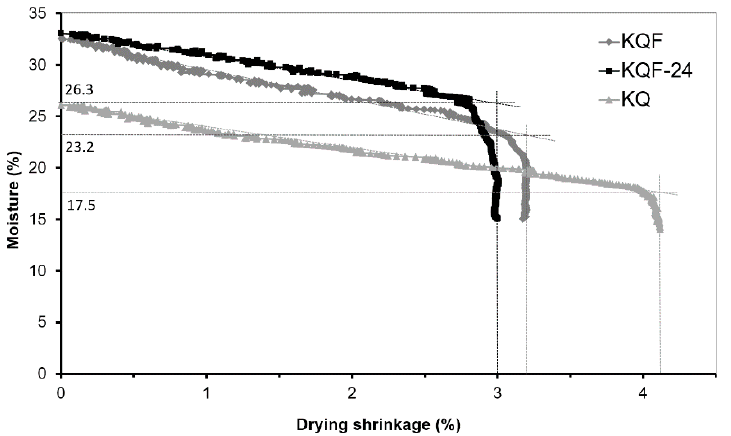
Figure 5. Bigot curves of KQF samples measured on fresh (KQF) and 24 h aged (KQF-24) test samples compared with a sample without CCFA (KQ).